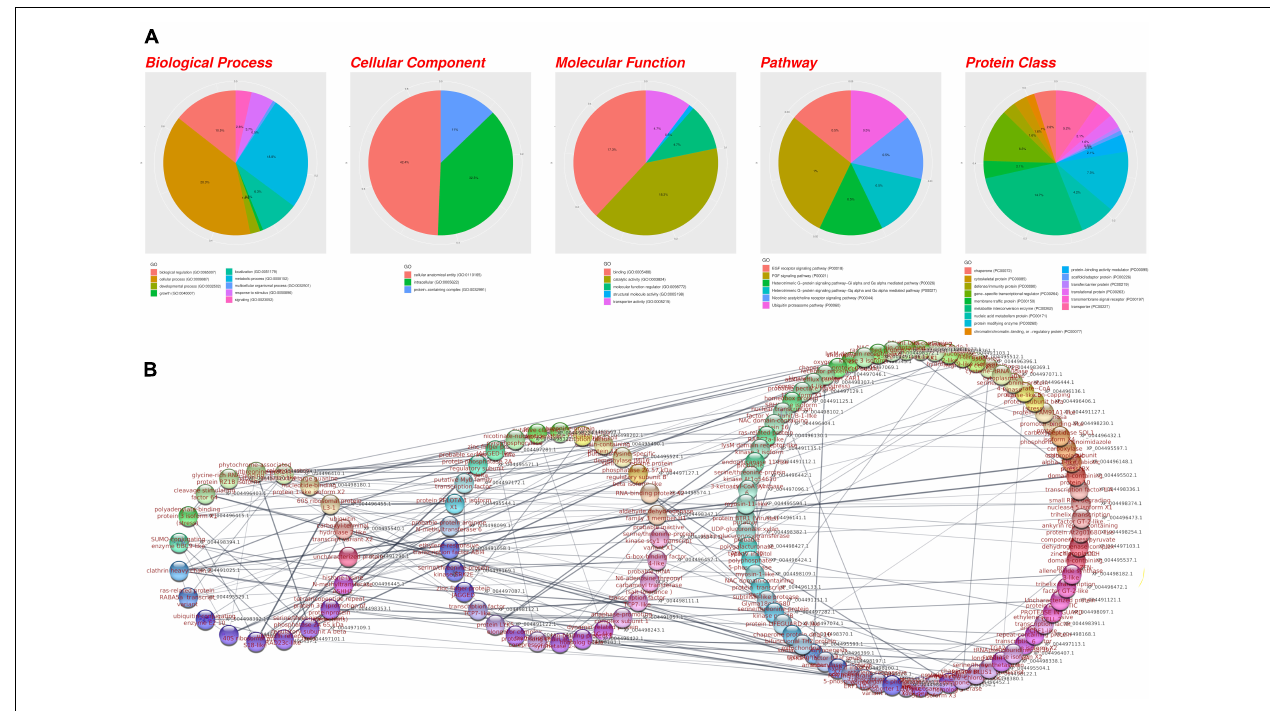
FIGURE 6 | (A) Gene Ontology analysis and (B) the protein-protein interaction network of potential candidate genes for AB resistance underlying the regions identified in the AB 3279 and AB 482 populations. The genes are grouped by their interaction activity: high, medium, or low.